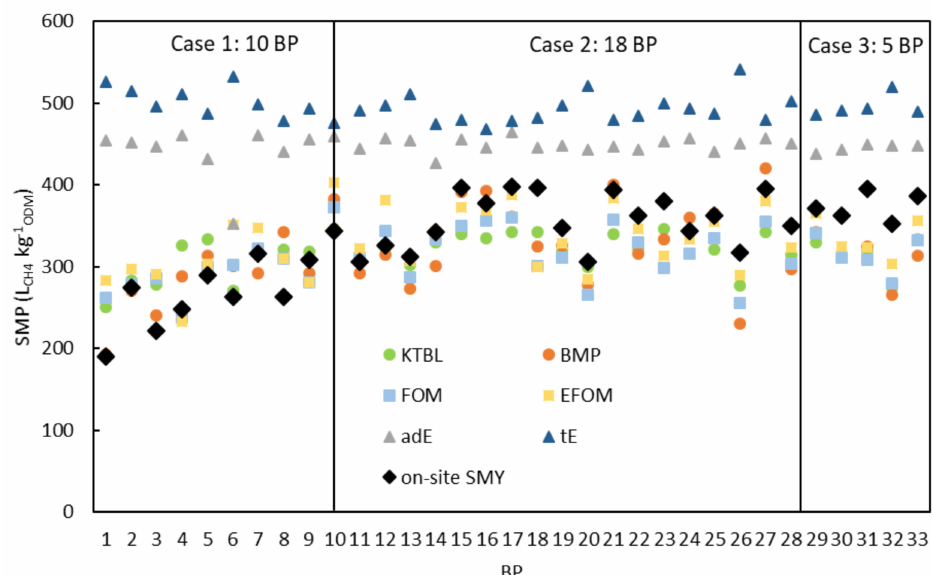
Figure 3. The specific methane potential (SMP) from substrate mixtures of 33 biogas plants (BP) determined by literature values of Association for Technology and Structures in Agriculture (KTBL), biochemical methane potential test (BMP), fermentable organic matter (FOM), energy of fermentable organic matter (EFOM), anaerobically degradable energy (adE), total energy (tE) and the on-site measured methane yield (on-site SMY). BPs are separated according to three cases (Case 1: positive ODM and energy balance, Case 2: negative ODM balance and positive energy balance and Case 3: negative ODM and energy